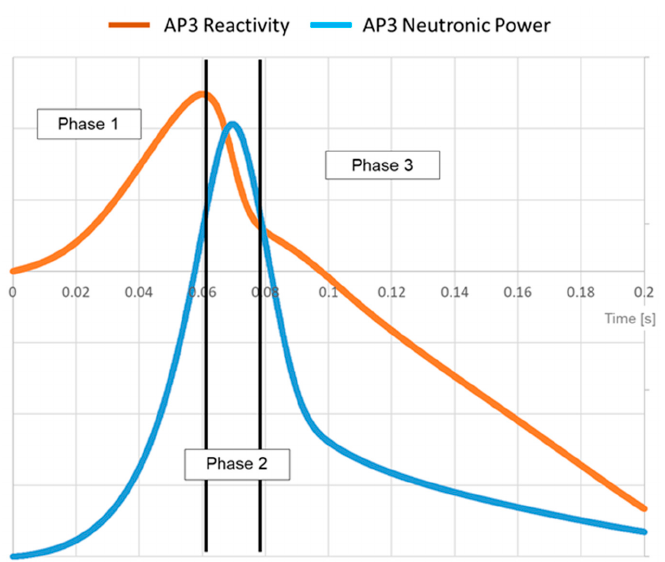
Figure 6. RIA transient analysis involving three phases for reactivity (orange) and power (bleu) time